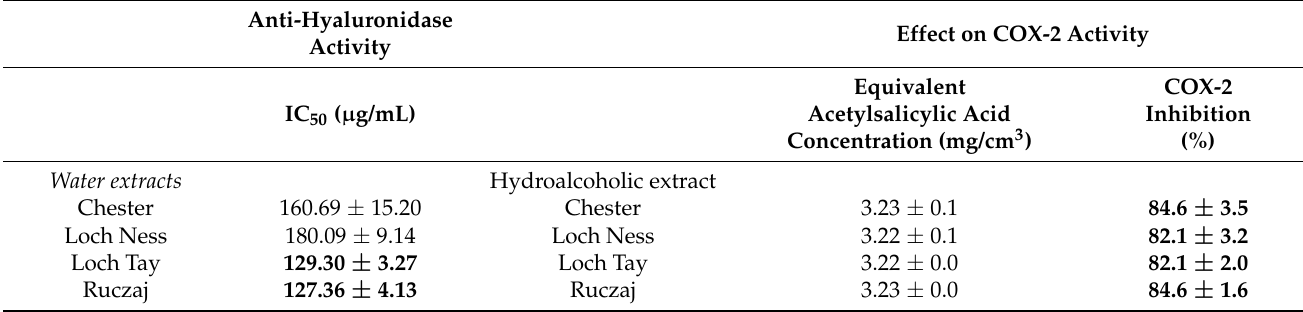
Table 6. Anti-inflammatory activity of blackberry leaves